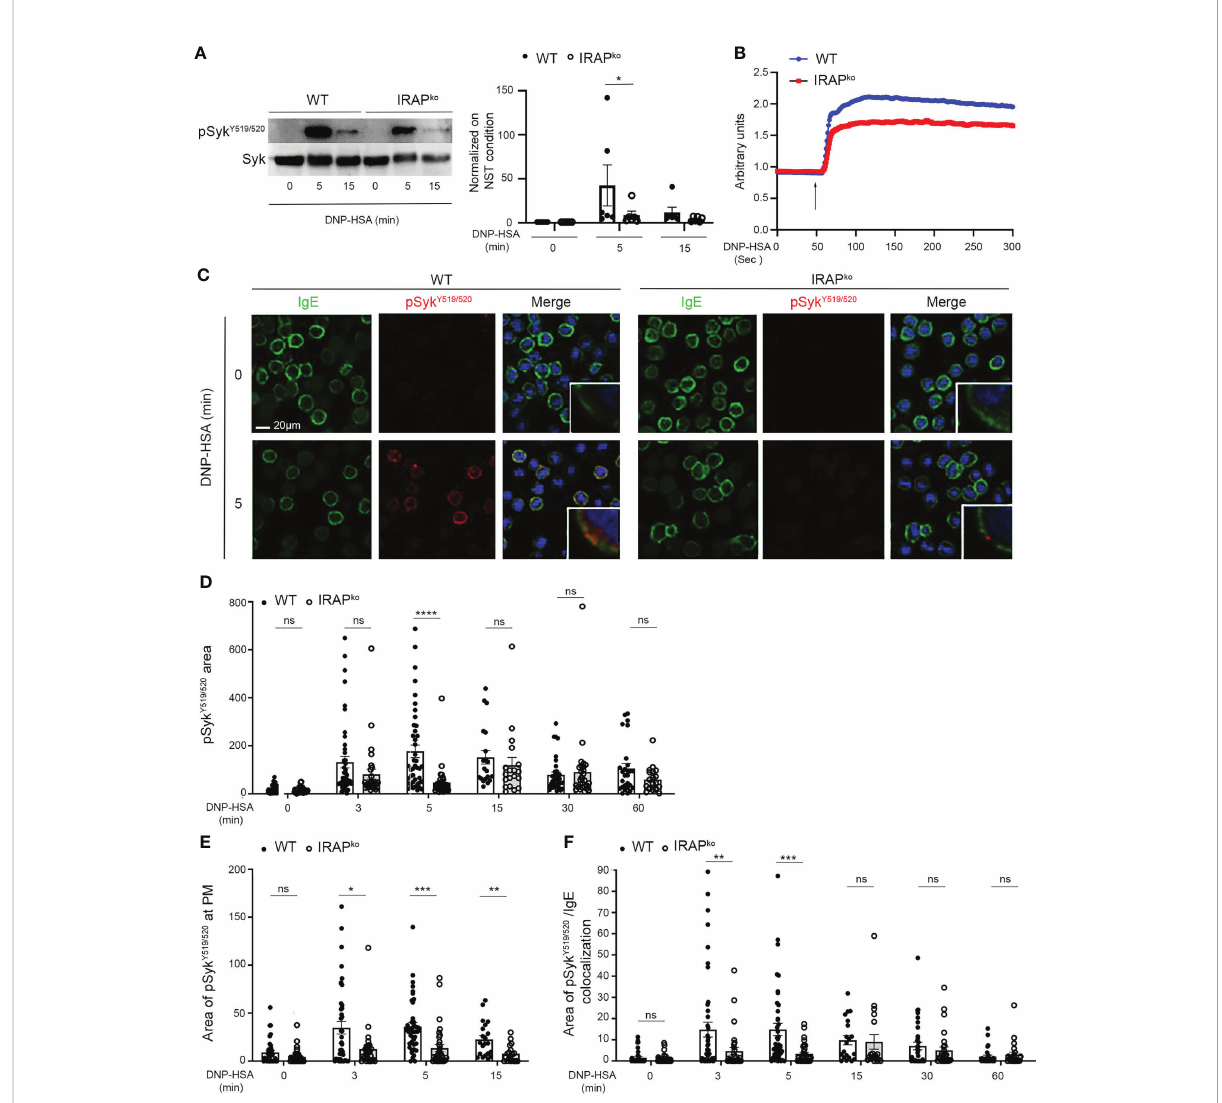
FIGURE 5 IRAP-de fi cient BMMCs show diminished phosphorylation of Syk at the plasma membrane where it colocalizes with IgE. (A) WT and IRAP- de fi cient (IRAP KO ) BMMCs were sensitized with anti-DNP IgE and challenged with antigen (30 ng/mL of DNP-HSA). Stimulation was arrested at indicated time points and cellular lysates were prepared in SDS sample buffer. Western Blot analysis (left panel) show pSyk staining (anti- pSyk Y519/520 ) and total Syk determined after stripping. Quantitative data (right panel) are the ratio between pSyk/Syk and were normalized by setting non stimulated values to 1. They represent the mean ± s.e.m of indicated experiments. Statistical analysis was done using the Wilcoxon test. (B) Anti-DNP IgE sensitized WT (blue) and IRAP KO BMMCs (red) were loaded with indo-1 and stimulated after addition (arrow) of 30 ng/mL of DNP-HSA. The fl uorescence emission ratio for Ca 2+- bound/Ca 2+- free indo-1 was measured. Similar results were obtained in three independent experiments. (C) Anti-DNP IgE sensitized WT and IRAP KO BMMCs were plated on fi bronectin-coated glass coverslips. Cells were stimulated with 30 ng/mL of DNP-HSA for indicated time points. After fi xation and permeabilization cells were stained with DAPI (blue), anti-IgE (green) and anti-pSyk Y519/520 (red) as indicated. Cells were analyzed by confocal microscopy. Images show representative sections with multiple cells for IgE and pSyk Y519/520 single staining as well as the merge of all colors. In the merge an insert with an enlarged cell membrane is shown to evidence colocalization. For a complete kinetic analysis see ( Supplementary Figure 4 ) . (D) The total amount of pSyk Y519/520 in both genotypes was determined for all time points examined. (E) The amount of pSyk Y519/520 appearing at the plasma membrane within the fi rst 15 min after stimulation was quanti fi ed. (F) The areas of colocalization between pSyk Y519/520 and IgE during the entire time of stimulation were quanti fi ed. (D – F) Data shown are presented as the mean ± s.e.m of indicated individual cells analyzed (pooled from 3 different experiments). Statistical analysis was done using the two-way ANOVA followed by Sidak ’ s post-hoc test. *: P < 0.05; **: P < 0.01; *** P < 0.001; **** P < 0.0001. ns, not signi fi